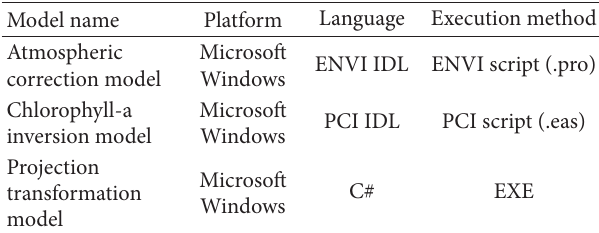
Table 2: Models and their runtime